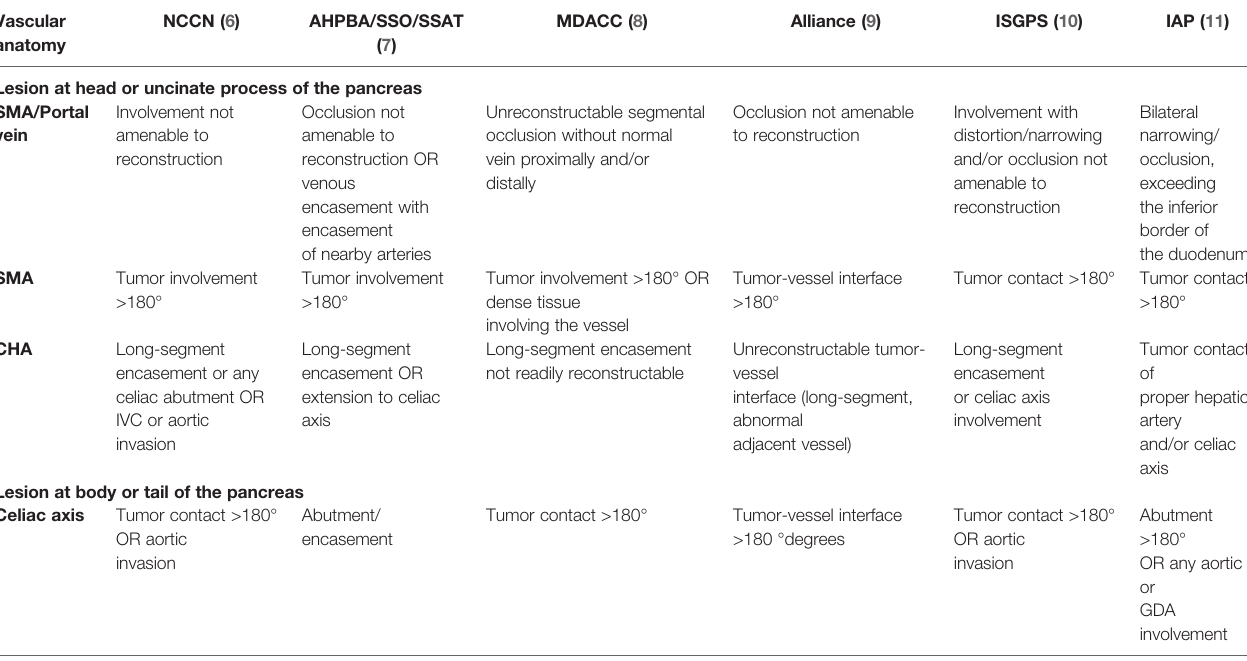
TABLE 1 | Locally advanced pancreatic cancer de fi nition according to different guidelines (5). Vascular